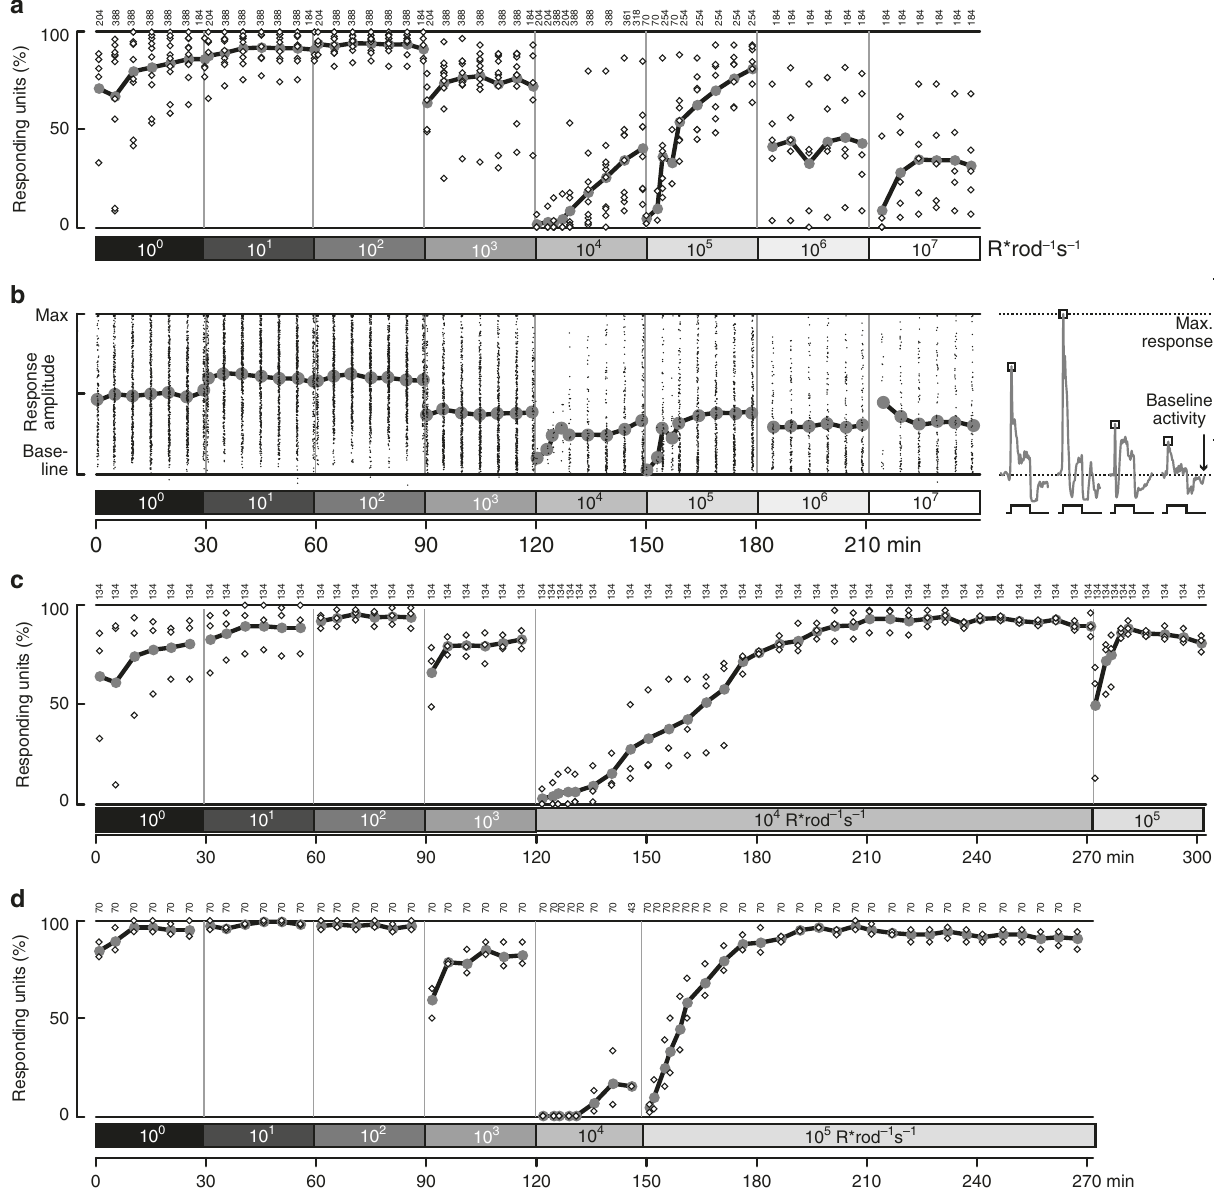
Fig. 3 Responsiveness of ganglion cells in isolated Cnga3 − / − retina. a Percentage of responsive ganglion cells in each retina (small white diamonds) and across all experiments (large gray disks and thick line) that responded to a full- fi eld positive or negative contrast step. The numbers on top indicate the total number of ganglion cells recorded at each time point of the experimental paradigm. b Response amplitude (normalized peak spike rate) of all individual units that responded (small dots) and their mean response amplitude (large gray dots and thick line). Right panel: Schematic of how response amplitude was determined. Each ganglion cell was followed throughout the experiment, and response strength was taken as the relative peak spike rate (indicated by squares) between the baseline activity of the cell and the cell ’ s maximal response. For simplicity, schematic shows only the positive contrast step. c Percentage of responsive ganglion cells in a subset of experiments ( n = 3 retinas) in which we stayed at 10 4 R* rod − 1 s − 1 for 2.5 h. Data from these retinas (up to 150 min) are also part of a and b . d Percentage of responsive ganglion cells in a subset of experiments ( n = 2 retinas) in which we stayed at 10 5 R* rod − 1 s − 1 for 2 h. Data from these retinas (up to 180 min) are also part of a and increased background light at 10-fold increments every 30 min, somewhat at all backgrounds. Counter-intuitively, the rate of this yielding 8 light levels from 1 to 10 7 R* rod – 1 s – 1 (2 × 10 8 to 2 × recovery was faster at brighter backgrounds. – 2 – 1 10 15 rod-effective photons cm s , Fig. 2a, b), and superimposed 2-s full- fi eld steps of positive contrast (+0.25 Michelson, +0.66 Weber) or negative contrast ( – 0.49 Michelson, – 0.66 Weber). The responses of a representative single ganglion cell are shown in Fig. 2c (positive contrast stimulus) and 2d (negative contrast). We presented blocks of fi ve repeats of this stimulus every 5 min (spike cell spiking activity from isolated cone-de fi cient ( Cnga3 – / – ) reti- raster shown on the left, average spike rate shown on the right). nas ( n = 10 retinas). Similar to the ERG experiments, we